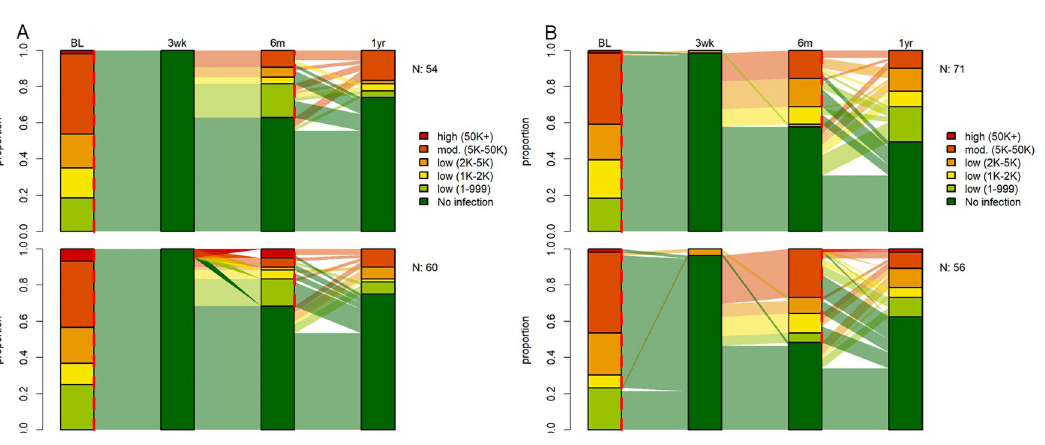
Fig 3. Proportion of infection intensities of A . lumbricoides at baseline, 14–21 days, six and 12 months post-treatment in Lao PDR (A) and Pemba Island (B) for ivermectin-albendazole above and albendazole-placebo below. 114 participants in Lao PDR and 127 participants on Pemba Island were initially infected with A . lumbricoides and had a complete data set. Red dashed lines at baseline and follow up represent treatment time points. Abbreviations: BL, baseline assessment; N, number of participants with a complete data set; 3wk, 14–21 days post-treatment follow-up; 6m, 6 months post-treatment follow-up; 1yr, 12 months post- treatment